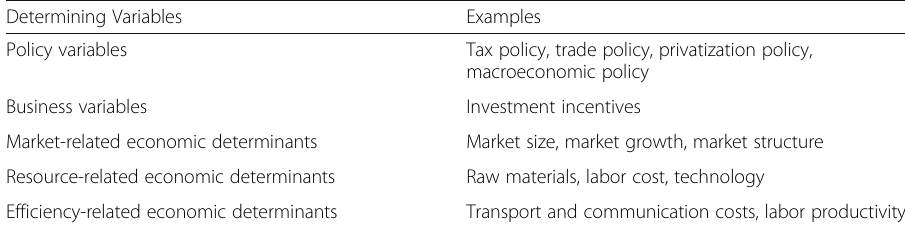
Table 2 UNCTAD ’ s Classification of FDI